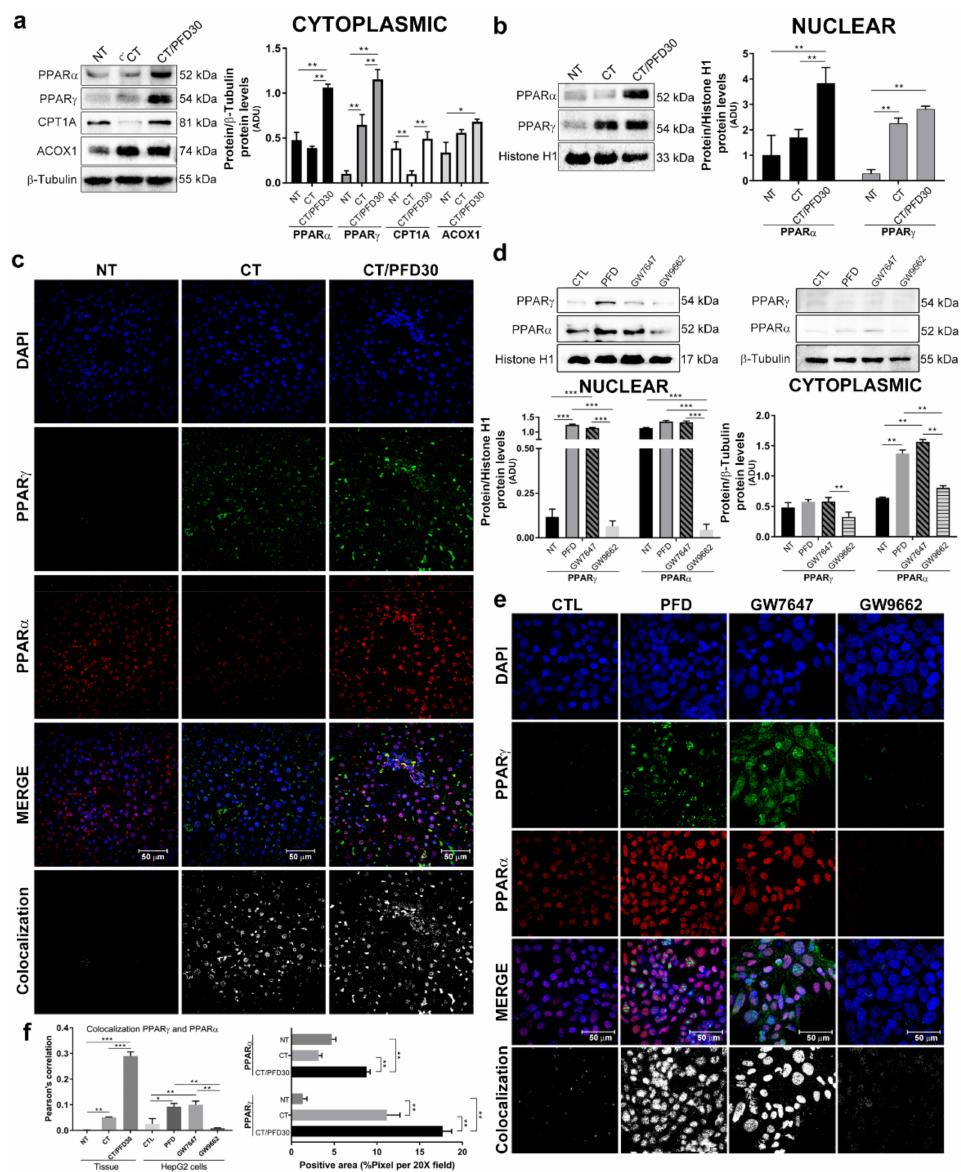
Figure 6. PFD administration induces overexpression and nuclear translocation of PPAR α and PPAR γ in the MRHM and HepG2 cells. ( a ) PPAR α , PPAR γ , CPT-1 and ACOX-1 cytoplasm expression. ( b ) PPAR α and PPAR γ nuclear expression. ( c ) IF for PPAR α (red), PPAR γ (green) and DAPI (blue) in tissues from MRHM. ( d ) PPAR α and PPAR γ in nucleus and cytoplasm expression respectively in HepG2 cells treated with PFD 500 µ M, GW7647 1 µ M and GW9662 100 nM. ( e ) IF for PPAR α (red), PPAR γ (green) and DAPI (blue) in HepG2 cells treated with PFD, GW7647 and GW9662. ( f ) Left panel: Pearson’s correlation of co-localization for PPAR γ /PPAR α in rats from MRHM and HepG2 cells treated with PFD, GW7647 and GW9662. Right panel: Quantification of positive area in histological sections for PPAR α and PPAR γ ; 50 µ m scale bars. Each bar represents the average value of ten rats or tripled HepG2 cells treatment. NT: No-treatment group; CT: Complete carcinogenic treatment group; CT/PFD30: Complete carcinogenic treatment plus PFD administration; PFD: pirfenidone. * p < 0.05. ** p < 0.01. *** p <